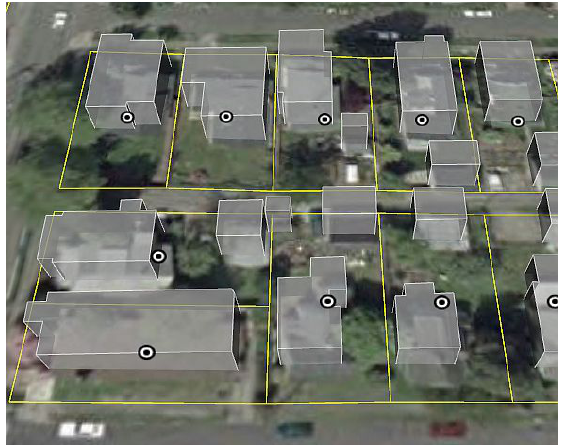
Figure 1. Buildings extruded and uploaded in Google Earth.